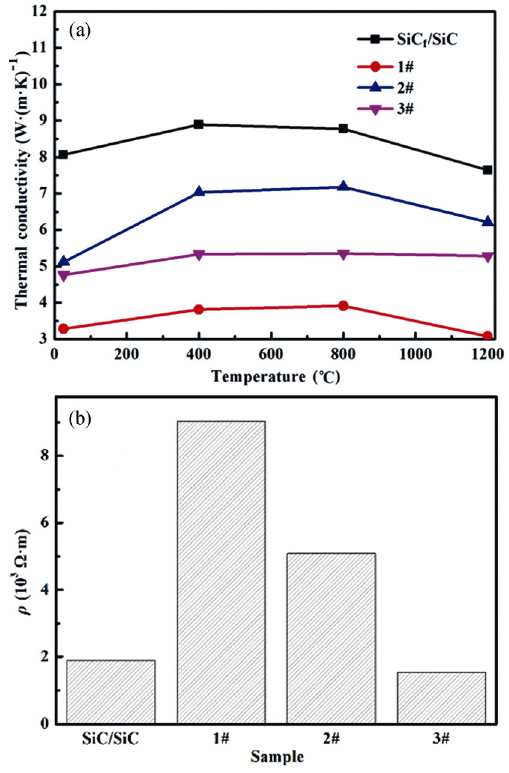
Fig. 8 (a) Thermal conductivity and (b) electric resistivity of as-fabricated